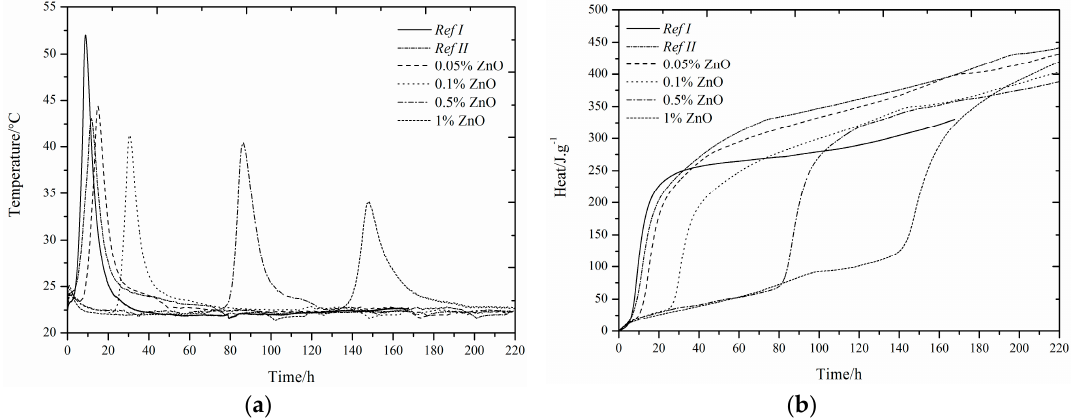
Figure 5. Differential ( a ) and integral ( b ) curves measured for the addition of ZnO. Figure 5. Di ff erential ( a ) and integral ( b ) curves measured for the addition of ZnO.